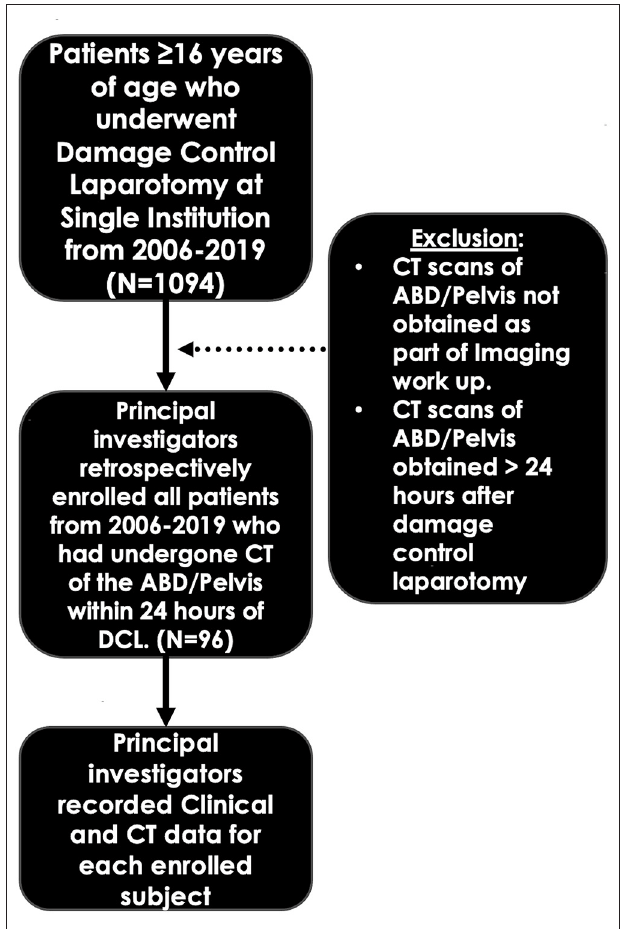
FIGURE 1 | Patient selection